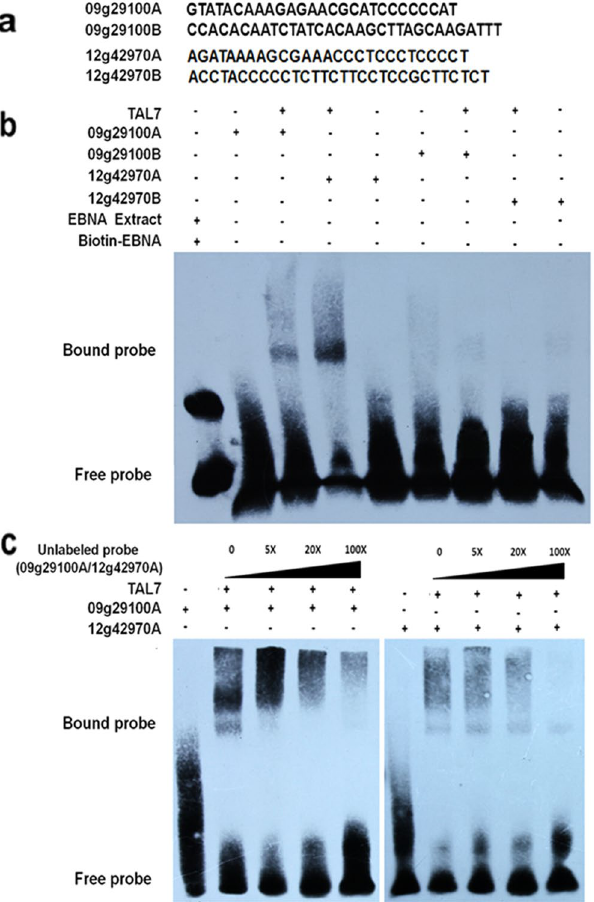
Figure 4. Xoc Tal7 binds the EBEs of the Os09g29100 and Os12g42970 promoter regions. Electromobility shift assays (EMSA) were performed using 20 fM biotin-labeled DNA fragments derived from the two promoter regions as probes. Unlabeled probes were used as competitor DNA. The presence of DNA or protein is indicated by ( + ), and absence by ( − ). ( a ) The DNA sequences of the four probes for EMSA, 09g29100A, 09g29100B, 12g42970A and 12g42970B, are shown at the top of the panel. ( b ) EMSA results for the probes from Os09g29100 and Os12g42970 . EBNA extract protein and biotin-EBNA coming from EMSA Kit (Thermo, USA) used as positive contral. ( c ) Competition of the biotinylated probes with unlabeled incubated with His-Tal7. Unlabeled probe 09g29100A and 12g42970A were incubated at increasingly higher concentrations; e.g. 5, 20, and 100 X times more than the 20 fM of biotinylated 09g29100A and 12g42970A, respectively. The experiments were repeated two or more times with similar